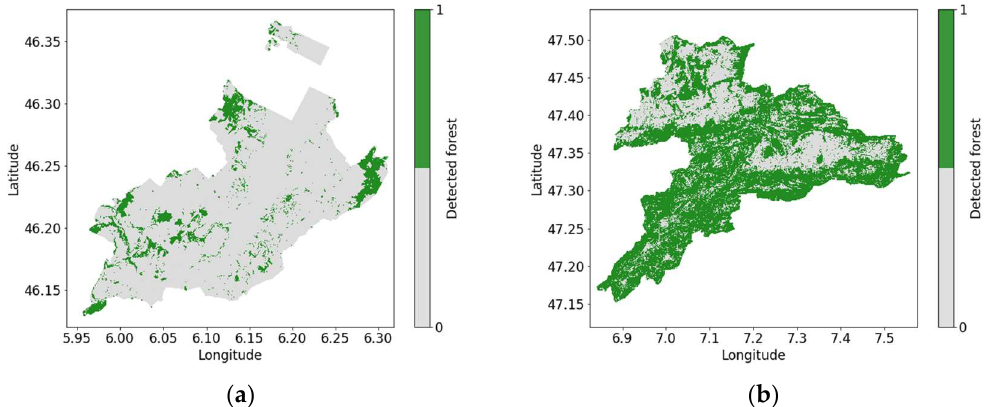
Figure 4. Forest coverage in the canton of Geneva ( a ) and canton of Jura ( b ) estimated by the forest detection algorithm. The time period refers to the years 2013–2017.